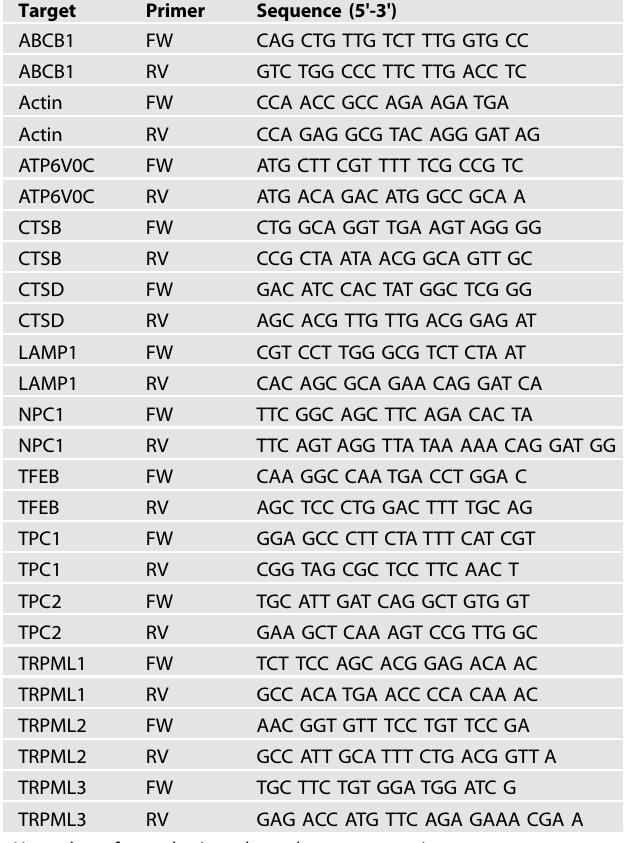
Table 1. Primers for